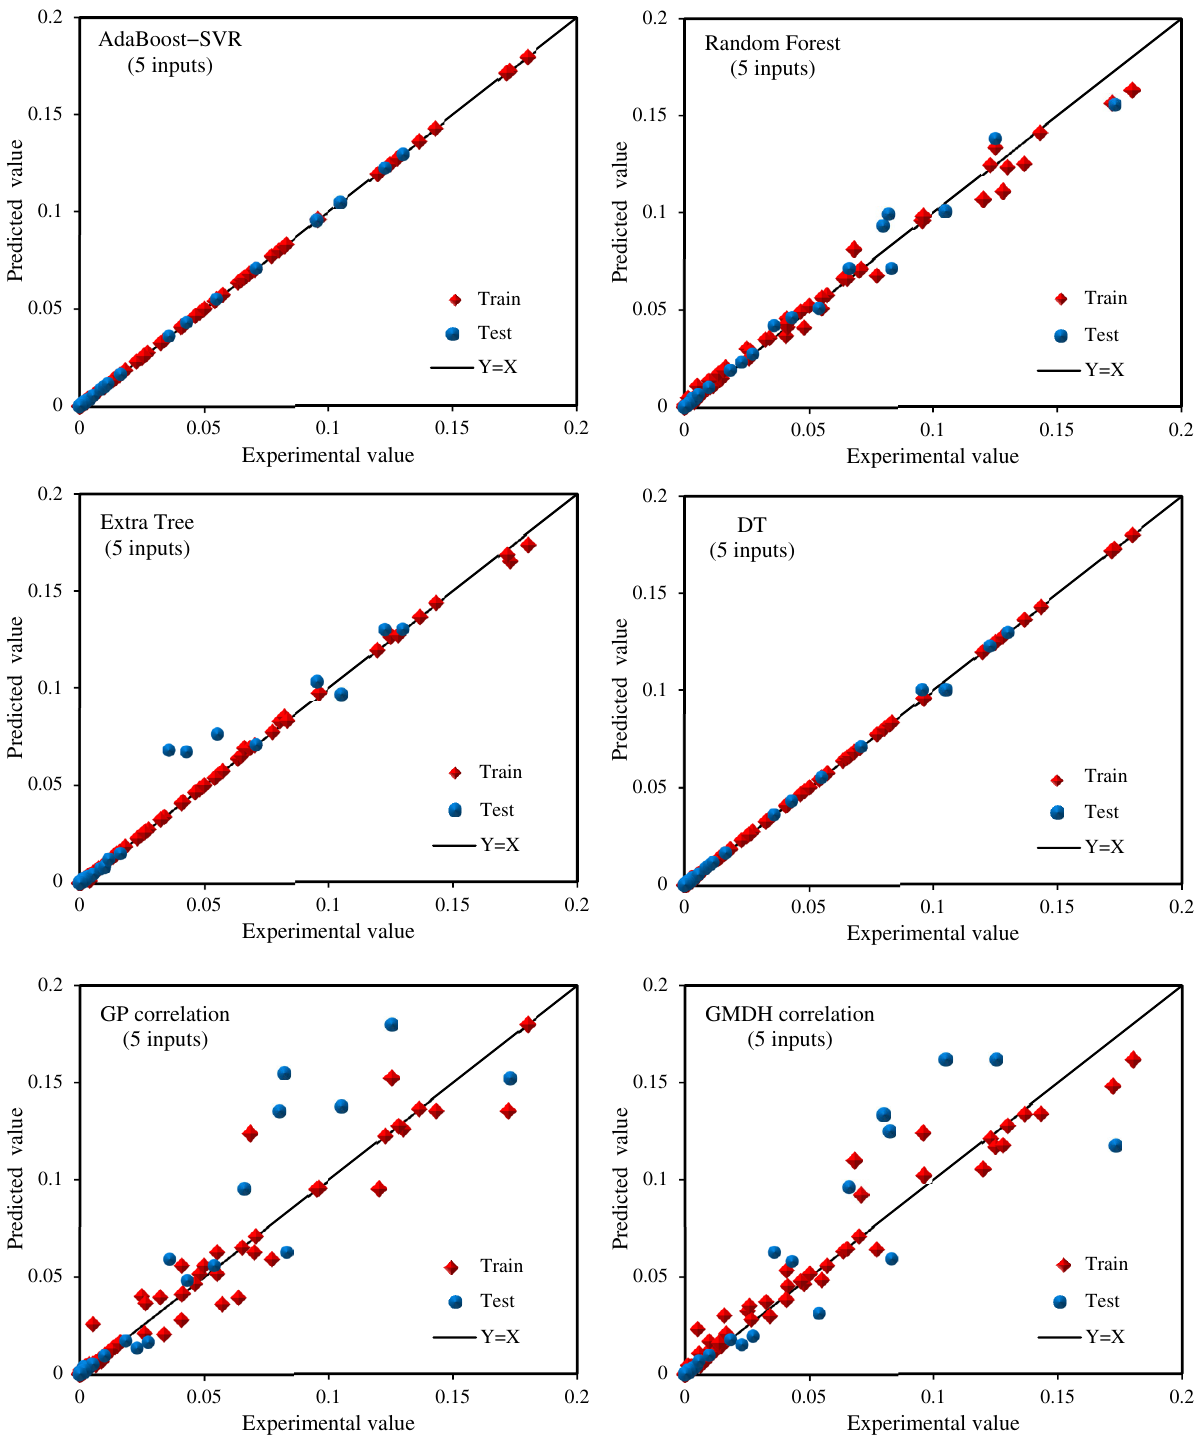
Figure 4. Cross-plots of the developed machine learning models and mathematical